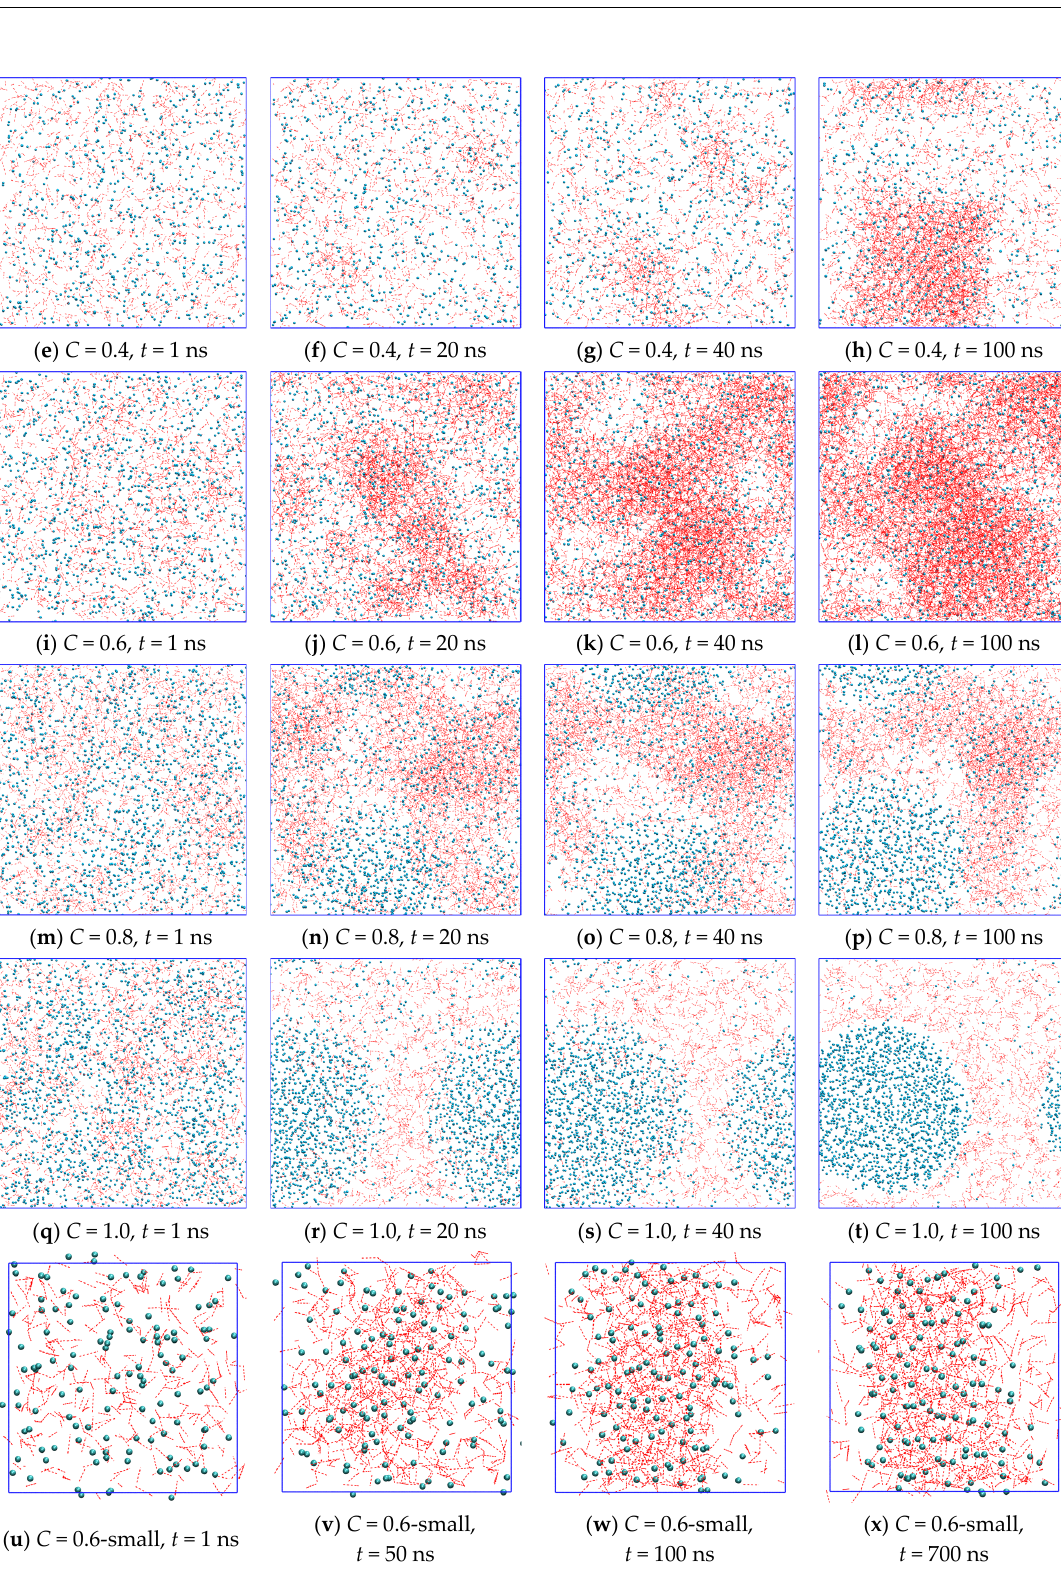
Figure 5. Spatial distribution of H-bonds and gas molecules in the methane + water solution at concentrations of ( a – d ) C = 0.2, ( e – h ) C = 0.4, ( i – l ) C = 0.6, ( m – p ) C = 0.8 and ( q – t ) C = 1.0 at simulation time points: 1 ns, 20 ns, 40 ns, and 100 ns and ( u – x ) for replicated 3 × 1 × 1 times C = 0.6-small at time points 1, 50, 100, and 700 ns. Coordinates of water molecules are averaged over 1 ns in order to show the stable hydrogen bonds (red dashed lines). Hydrate-like structure growth at C = 0.8 is not